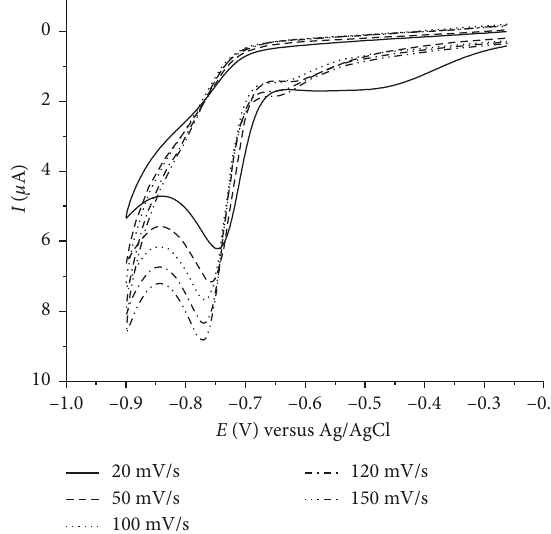
Figure 1: Cyclic voltammograms of 0.5mol/dm 3 diazepam on glassy carbon electrode as a function of a scan rate (20–150 mV s